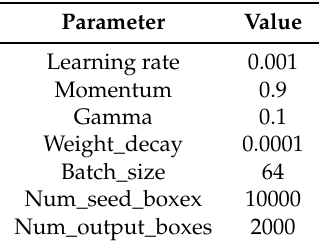
Table 3. Overview of the related